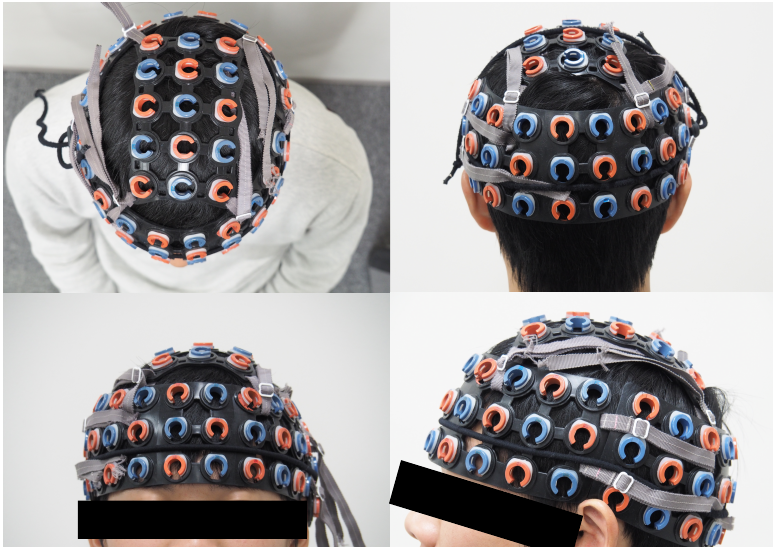
Figure 2. Probe set configuration. Red circles indicate emitters and blue circles indicate detectors. A 3 × 10 probe set (47 channels) was attached to each of the forehead and occipital regions, and a 3 × 5 probe set (22 channels) was attached to the top head region. In total, 116 channels were measured for the whole